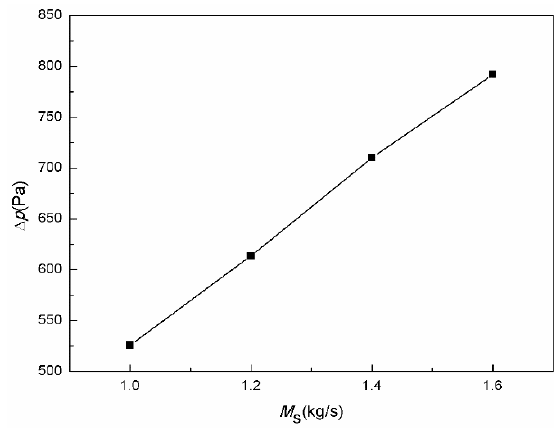
Figure 12. Influence of the sinter flow rate on the pressure drop.